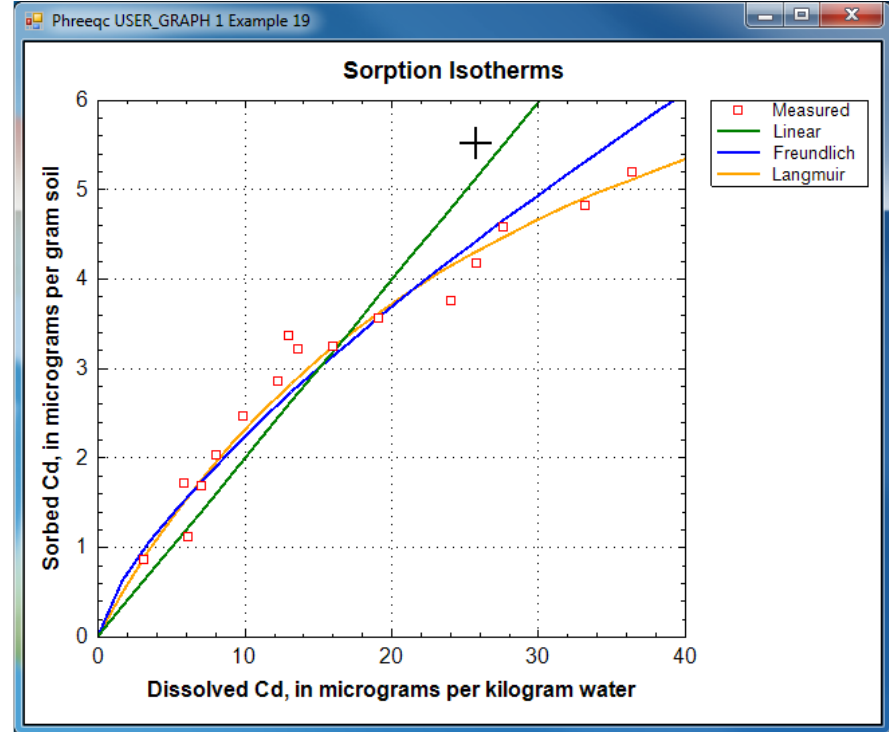
Figure 19. Measured sorption of Cd on loamy soil and three isotherms calculated by